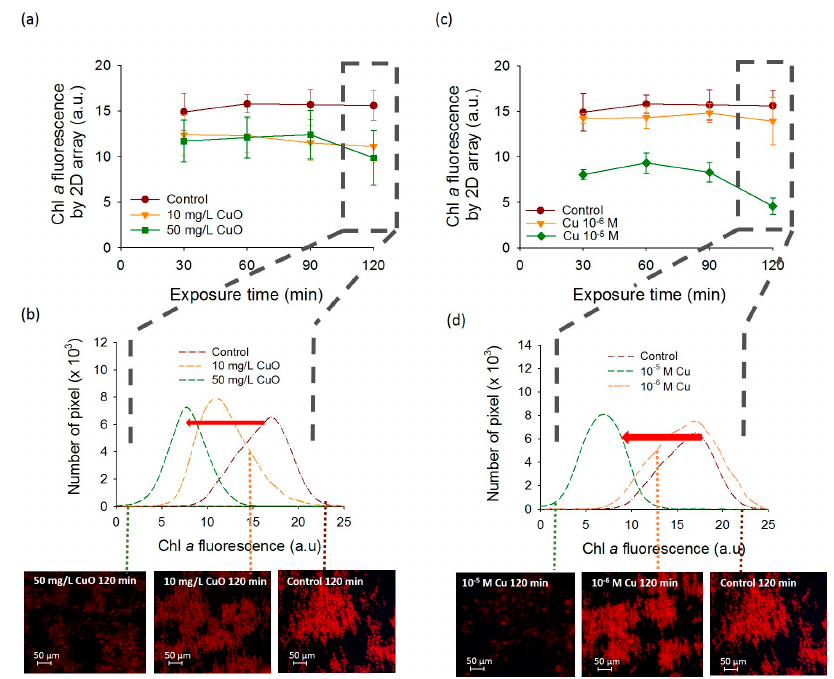
Figure 3. CuO-NPs and Cu-induced effects on the fluorescence of C. reinhardtii obtained by the 2D-array. Time course of the mean corrected fluorescence intensity ( CF ) per pixel of cells assembled in 2D-array by DEP exposed to increasing ( a ) CuO-NPs and ( c ) Cu concentrations. The data values are average and standard deviation from three replicates. Examples of the number of pixels obtained with the 2D-array versus corrected fluorescence of chlorophyll after 120 min of exposure time and illustrative microscopy images of chlorophyll fluorescence 2D-arrays with increasing ( b ) CuO-NPs and ( d ) Cu concentrations.